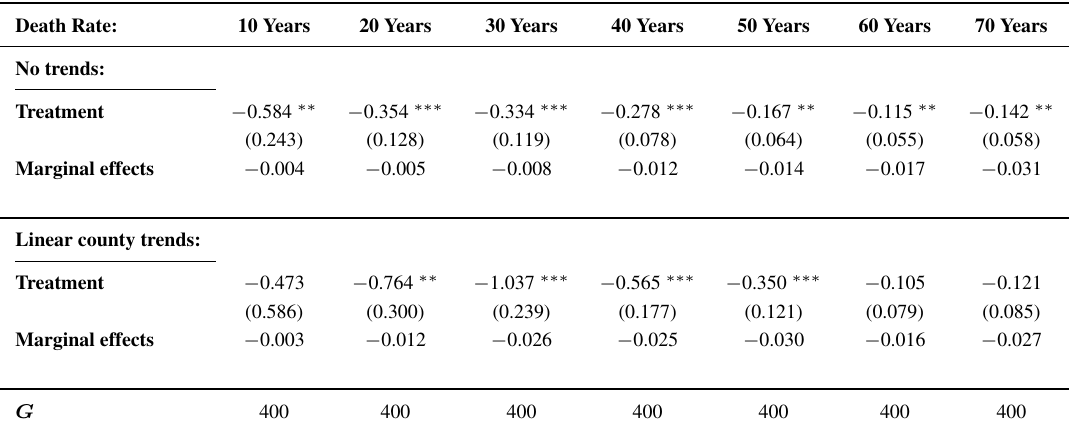
Table 6. Logistic regression: main